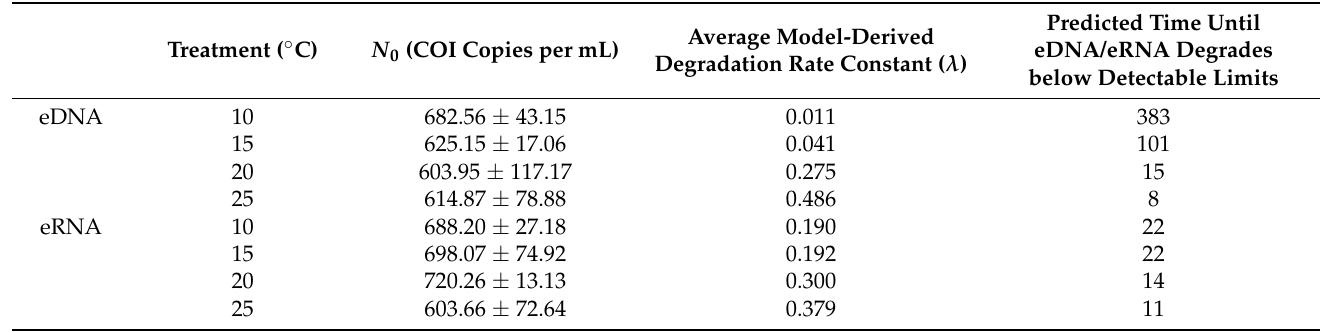
Table 3. Degradation rate constants and estimated hours until Fenneropenaeus chinensis eDNA/eRNA degradation at four temperatures (10, 15, 20 and 25 ◦